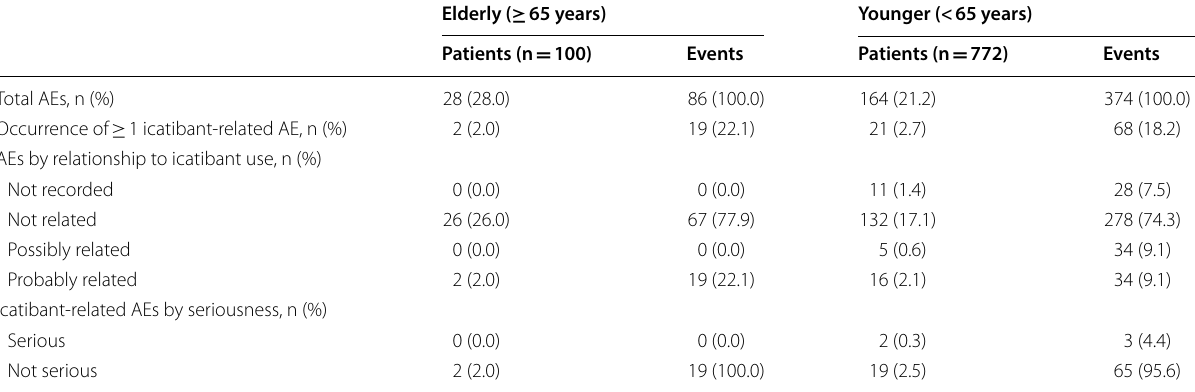
Table 4 Overall summary of